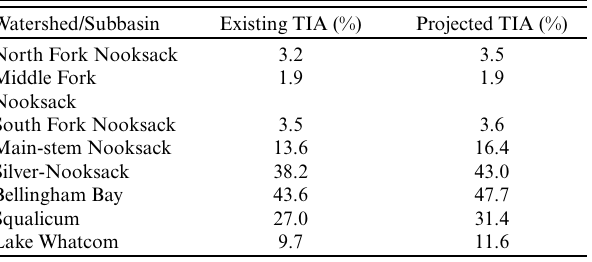
Table 2 . Total impervious surface area (TIA) in selected Whatcom County subbasins: current values and 20-year growth projections. Excerpted from table 4.3-3 in Whatcom County Planning and Development Services (2015).